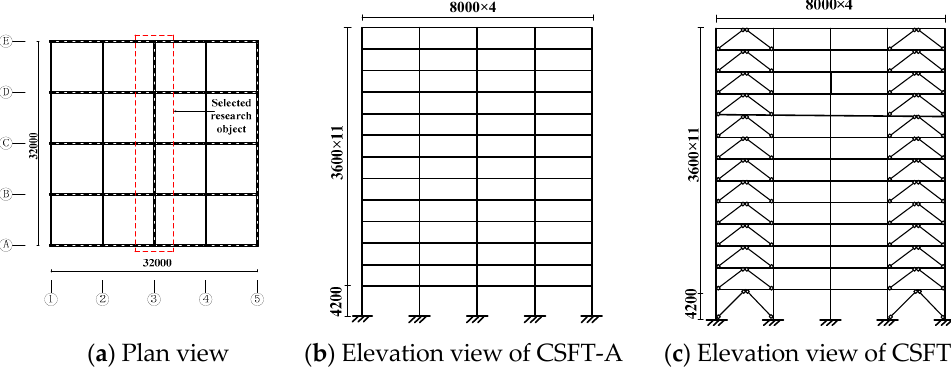
Figure 6. Layout of the exemplar structures (unit: mm).